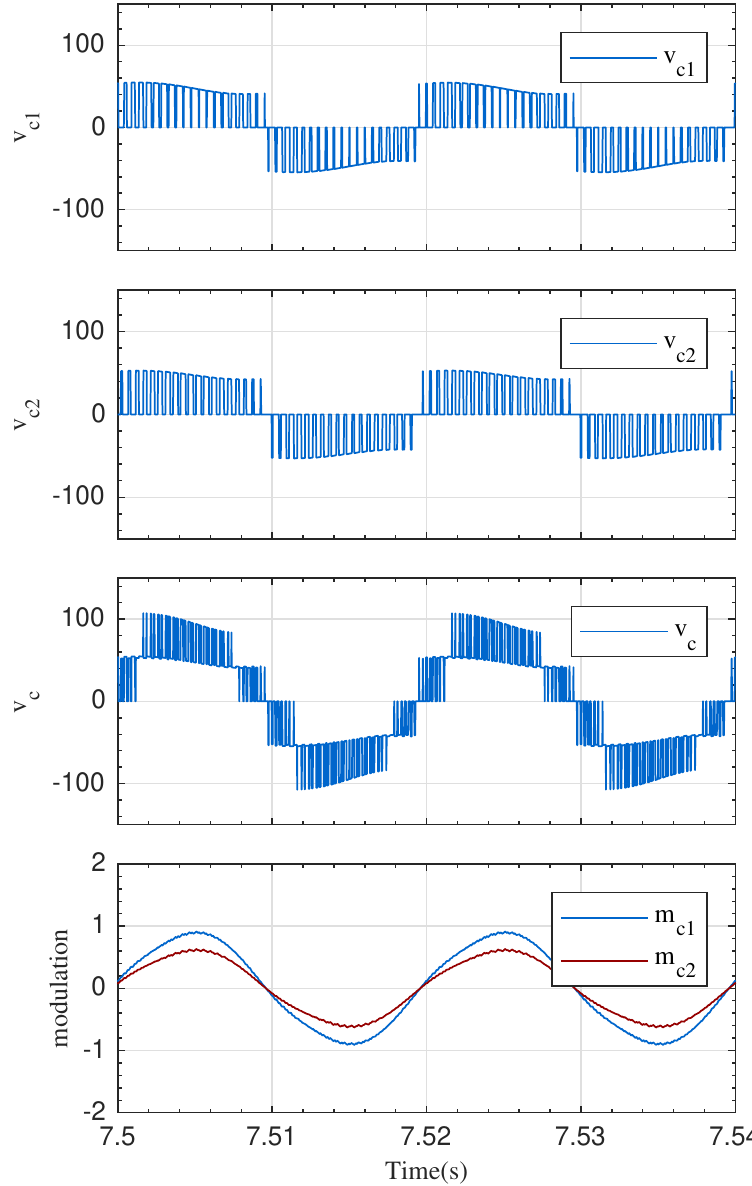
Figure 10. Steady-state converter output voltage performance under unbalanced power per string.